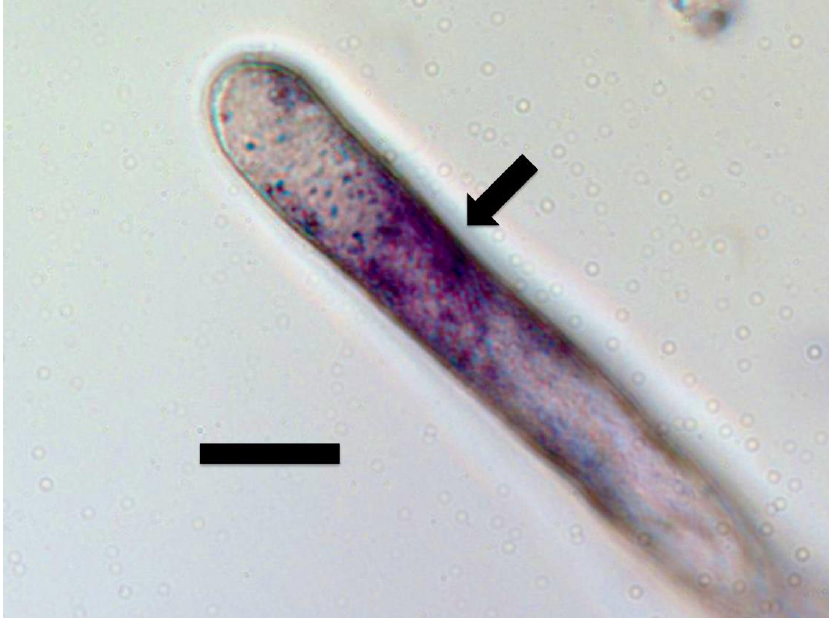
Figure 4. Tall fescue seedling root hair filled with bacteria and stained with 0.1% nitro blue tetrazolium showing superoxide (purple color) around bacterial protoplasts in the hair (arrow; bar = 15 µm).